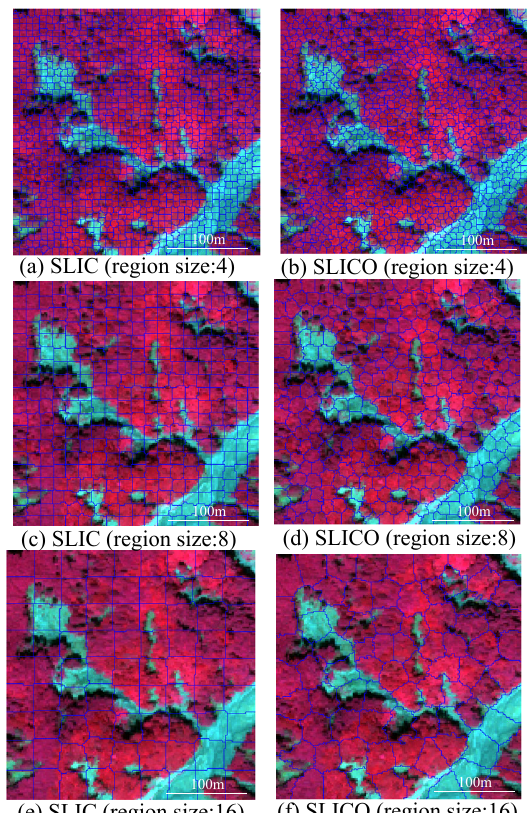
Figure 6. Comparison of segmentation in area